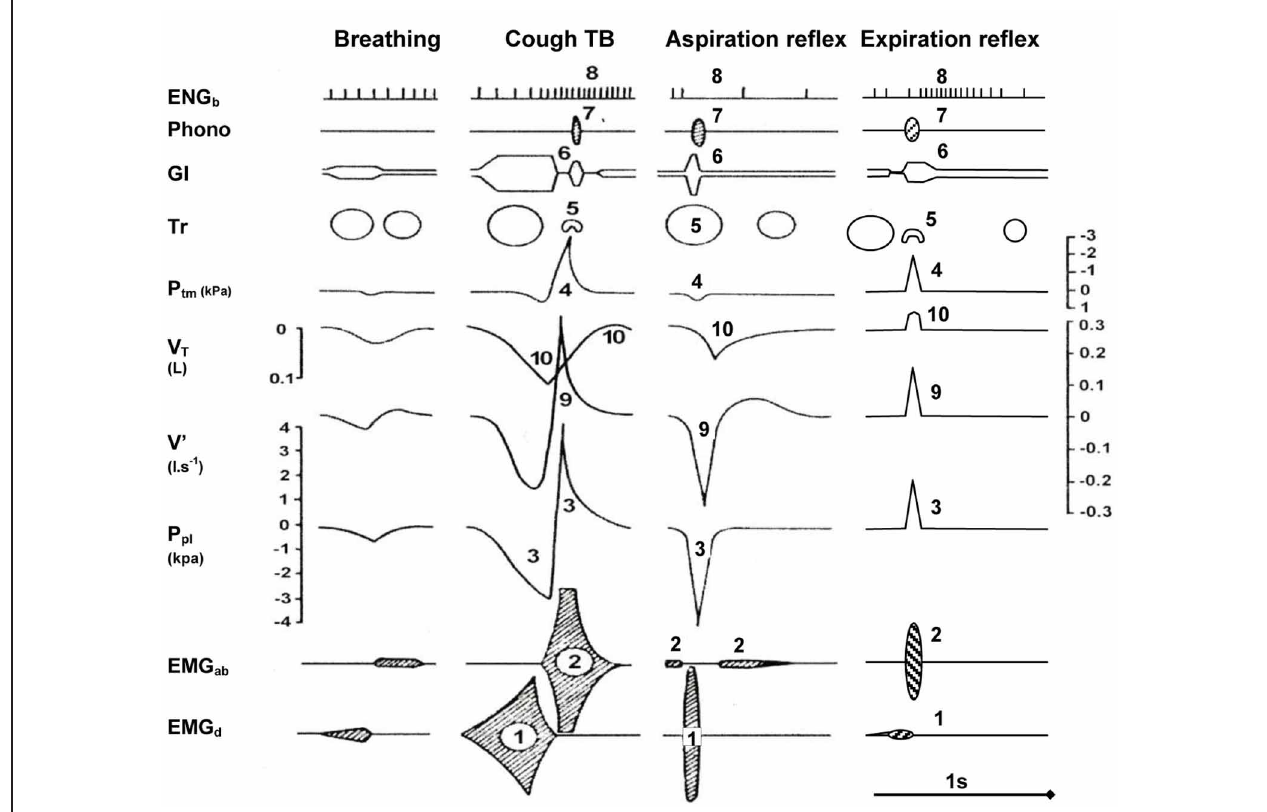
FIGURE 2 | Main components of selected airway reflexes compared to quiet breathing. Schematic illustration of 10 main components (indicated by numbers) during one cycle of AspR and ExpR, compared with the cough reflex and quiet breathing in the anesthetized cat. Abbreviations: (1) EMG d , diaphragmal electromyogram; (2) EMG ab , abdominal electromyogram;